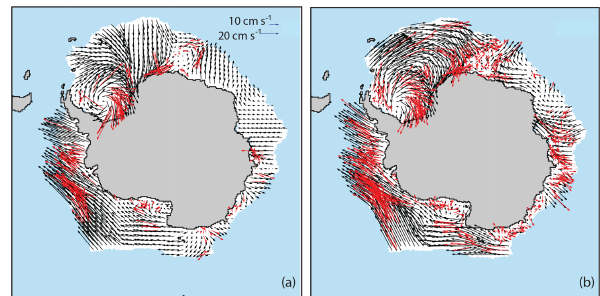
Figure 3. U component of the daily interpolated vector field for 17 September 2001 from (a) Version 3 and (b) Version 4. The Version 3 fields show sharp gradients in the velocity when highly weighted buoy estimates – buoy locations shown with red dots – no longer contribute to the motion field. Version 4 removes these sharp gradients by considering the highest weighted – rather than closest – underlying estimates.